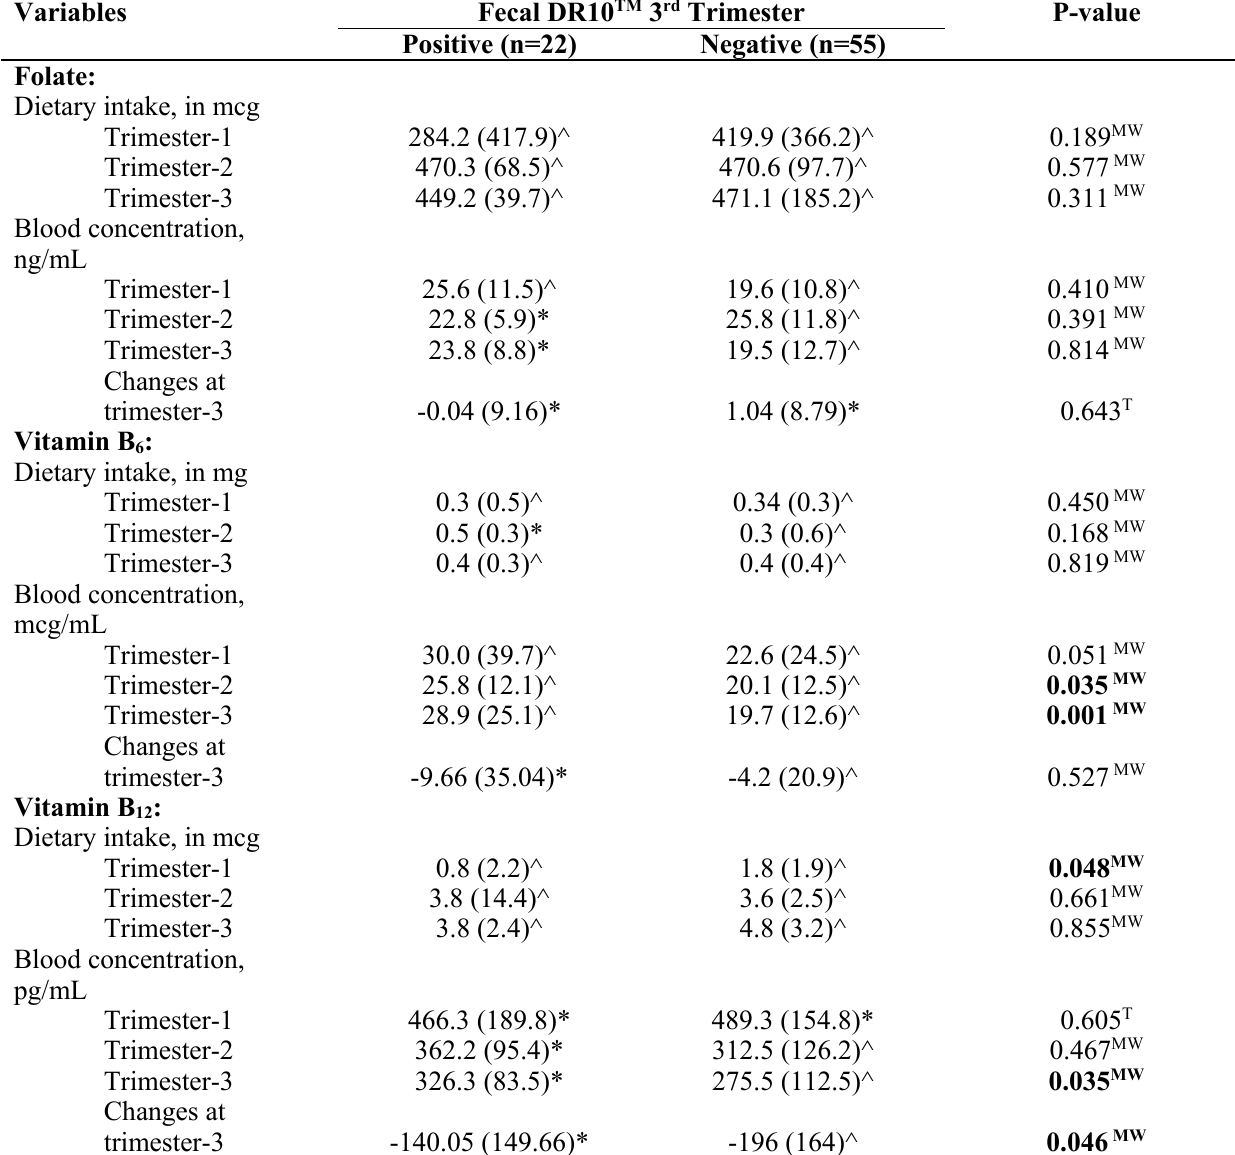
status during pregnancy by the existence of fecal DR10 TM at the third